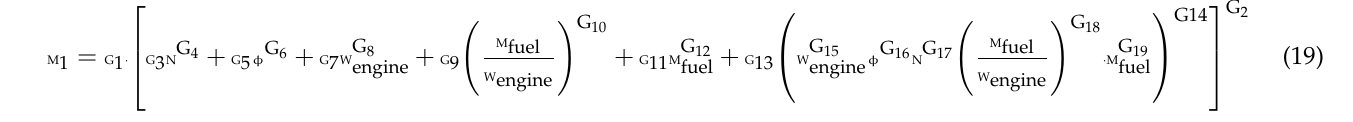
Figure 13. This figure shows the IMEP adaptive physics-based model’s tuning constants and their trimmed mean: ( a ) a 0 constant values; ( b ) a 1 constant values; ( c ) a 2 constant values; ( d ) C 1 constant values. The second method was a static parameterization approach that utilized the GRG algorithm to find global tuning constants for the whole operating point set. For this second approach, a regressor (based on similar argumentation to that given in [35]) given by Equation (19) was developed to globally fit the constants obtained from the online parameterization. The G i terms are the resulting global model constants obtained for the physics-based IMEP model.